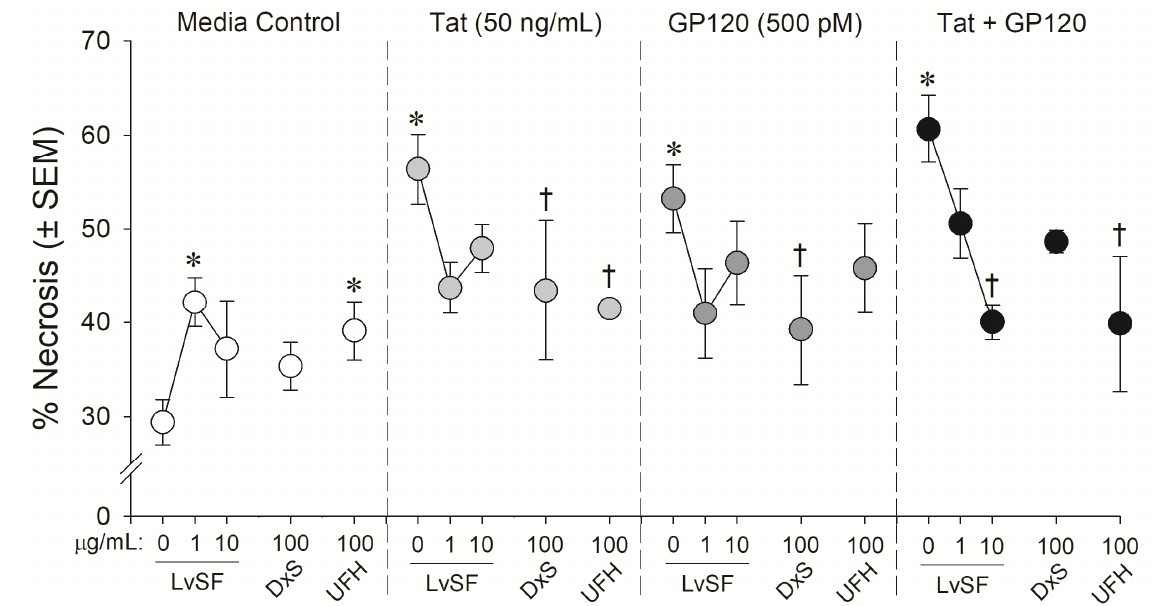
Figure 4. Neuronal cell death among C57BL/6N, striatal, medium spiny neurons co-exposed to Lytechinus variegatus -derived sulfated fucan (LvSF; 1 and 10 μ g/mL), high-molecular weight dextran sulfate (DxS; 100 μ g/mL), unfractionated heparin (UFH; 100 μ g/mL), HIV-1 Tat (50 ng/mL), and/or HIV-1 gp120 (500 pM). * indicates significant increase in necrosis compared to untreated media control. † indicates significant protection from respective HIV-1 protein exposure. All points indicate the mean of 2–5 independent experiments (two-way ANOVA, p ≤ 0.05).